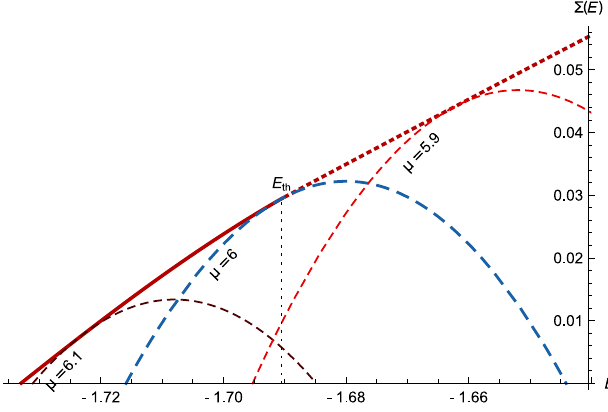
FIG. 2. Complexity Σ ð E; μ Þ of the ( 3 þ 4 )-spin model as a function of the energy E for different values of μ . The solid line ( E < E ) represents the complexity of the dominant stable th 6 ); its continuation above E minima ( μ > μ (short- mg ¼ th 6 ) represents the complexity of the dashed line, μ < μ mg ¼ dominant saddles. The parabolic long-dashed lines below represent the complexity fixing the radial reaction: μ ¼ 6 corresponds to marginal minima (dashed blue line), μ > 6 to stable minima, and μ < 6 to saddles. For the same value of E , stationary points of different nature coexist, and more impor- tantly, marginal states ( μ ¼ 6 ) exist in a broad energy range E ∈ ½ − 1 . 716 ; − 1 . 644 (cid:2)